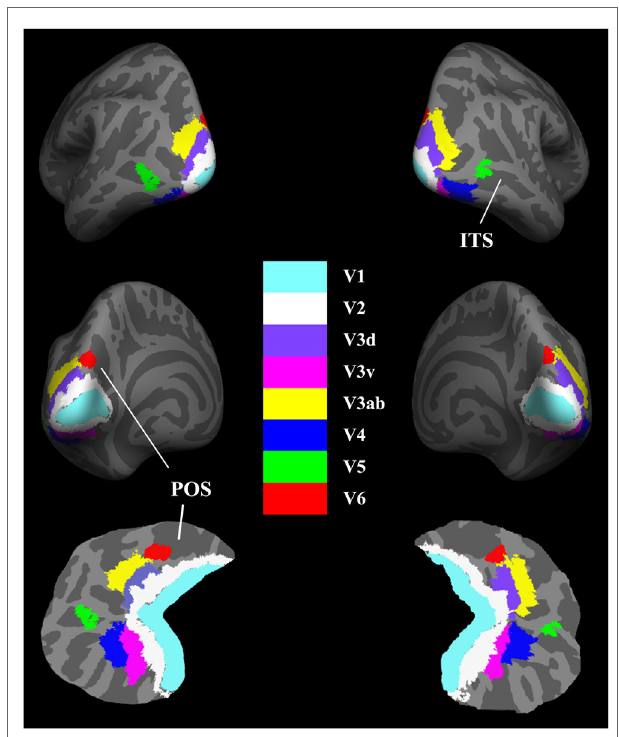
FigUre 1 | Maps of visual areas shown in lateral, medial, and flattened views of the bilateral hemispheres (rh) . Light gray indicates gyri (convex curvature); dark gray indicates sulci (concave curvature). The area V6 adjoins the borders of the medial-most parts of V3d and V3ab. ITS, inferior temporal sulcus; POS, parietal–occipital sulcus.